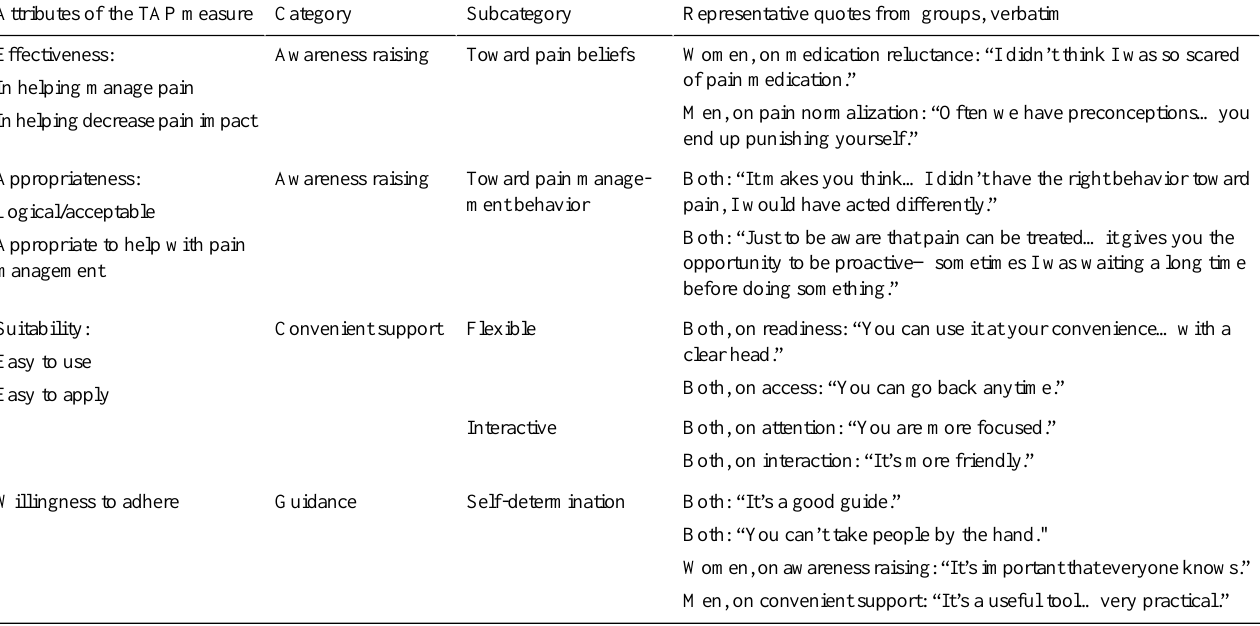
Table 6. Content analysis summary for women and